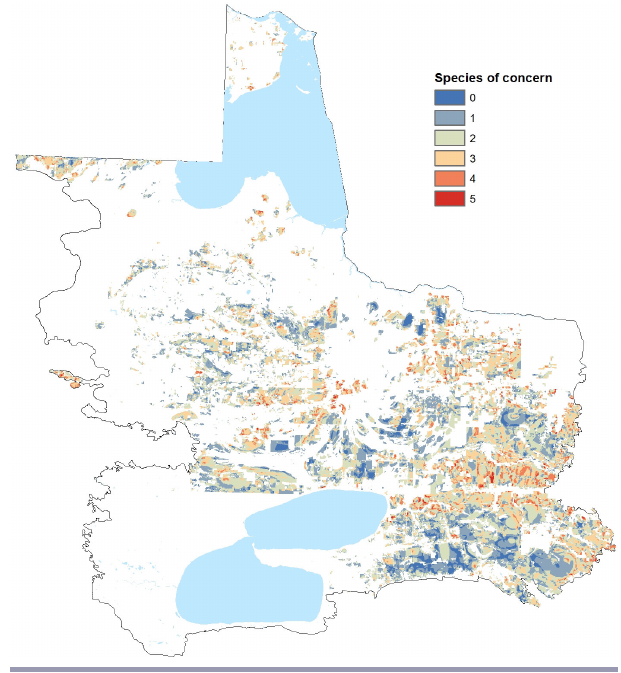
Fig. 3 . Number of Species of Greatest Conservation Need predicted to find suitable habitat within lowland conifer forests in the Agassiz Lowland Subsection. Individual species suitability maps for the five species in Figure 2 were transformed into binary maps based on the suitability values of the top 90% of model training data (see methods). Binary suitability maps were overlaid upon each other to identify the number of species predicted to have suitable habitat in a given